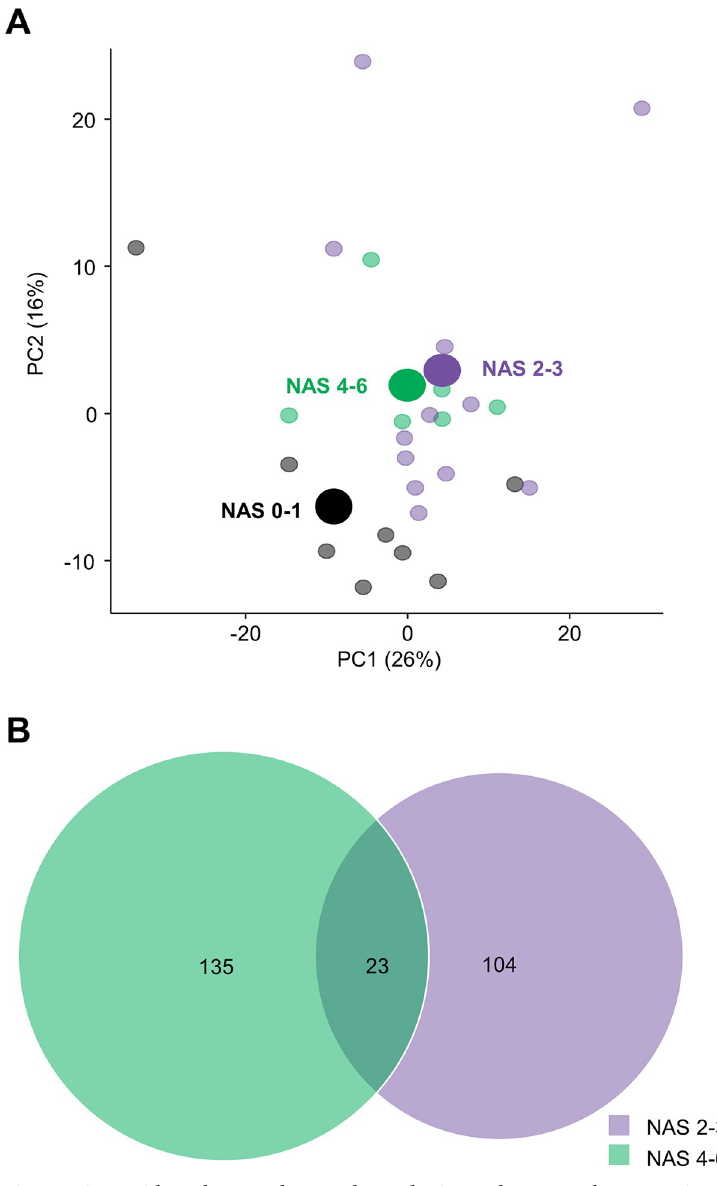
Fig 2. Patients with moderate and more advanced NAFLD cluster together separating from patients with no or mild NAFLD. (A) PCA plot of samples based on 500 most variable genes. Points indicate the relationship between liver biopsy samples (patients) across their gene expression profile. Color represent group defined by NAS score. (B) Venn diagram of DEGs compared to individuals with NAS 0–1 (false discovery rate, p < 0.05). Circles that overlap share DEGs. Abbreviations: DEGs, differentially expressed genes; NAFLD; non-alcoholic fatty liver disease; NAS, NAFLD activity score; PCA, principal component